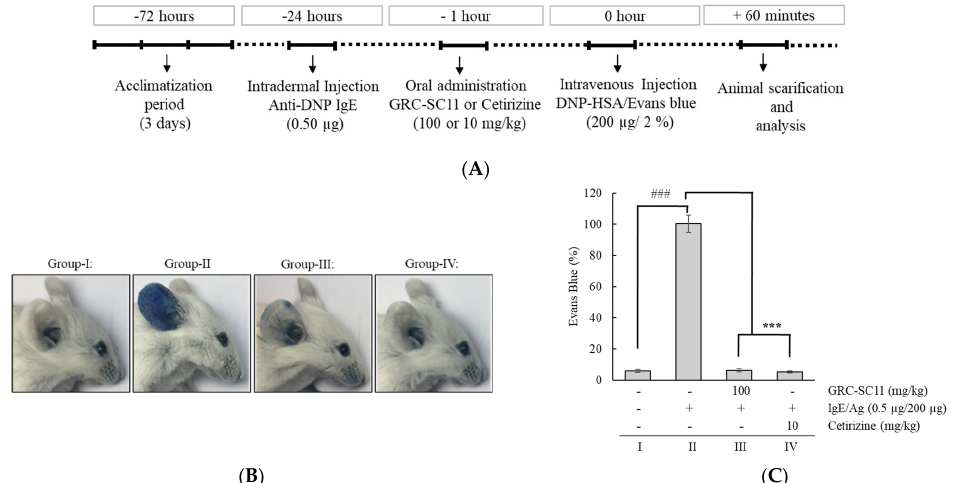
Figure 5. Effect of GRC-SC11 on the IgE/Ag-stimulated passive cutaneous anaphylaxis (PCA) BALB/c mice model. ( A ) Scheme of the PCA design. PCA was induced by subcutaneous injection of 0.5 μ g of DNP-specific IgE into the ear of male BALB/c mice for 24 h and followed by the intravenous administration of 200 μ g of DNP-bovine serum albumin (BSA) antigen having 2% Evans blue dye in the tail region. Anti-allergic activity of GRC-SC11 was assessed at the concentration of 100 mg/kg, while cetirizine was used as the standard drug (10 mg/kg). Group I: Normal control (non-treated). Group II: PCA disease control (0.5 μ g IgE, anti-dinitrophenyl (DNP) IgE sensitized and challenged with 200 μ g DNP-HAS + 2% Evans blue solution). Group III: PCA mice treated with GRC-SC11 (100 mg/kg). Group IV: PCA mice treated with the reference drug control (10 mg/kg). ( B ) Representative image of murine ear ( n = 7 mice/group). ( C ) The mean ± SD of extravasated dye ( n = 7 mice/group). Differences were significant at the level of ### p < 0.001 (compared with normal animals) and *** p < 0.001 (compared with normal PCA animals). Statistical analysis of results was performed through one-way ANOVA followed by Dunnett’s t -test.